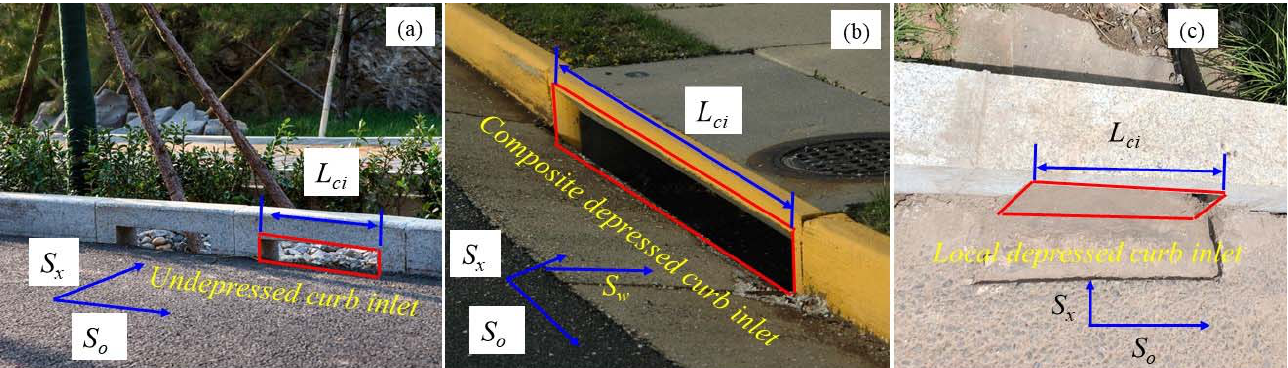
Figure 2. ( a ) Undepressed curb inlet photo taken in Jinan, Shandong province, China; ( b ) composite curb inlet example adapted from the website (https://www.leesburgva.gov, accessed on 18 June 2020), and ( c ) local depressed curb inlet photo taken in Ningbo, Zhejiang province, China.